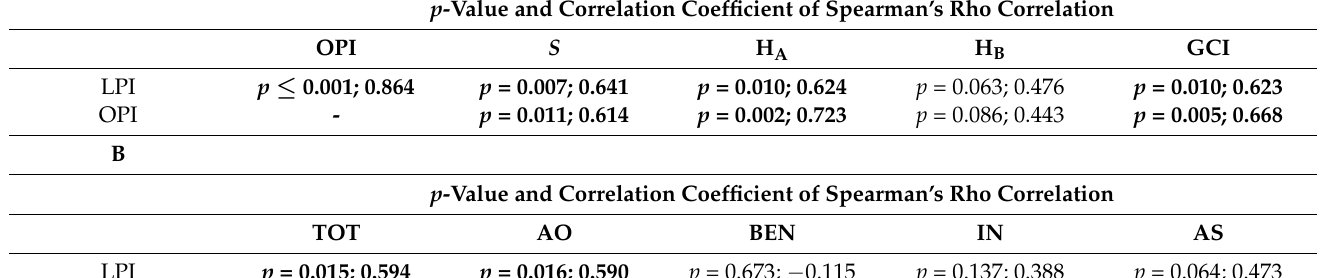
Table 5. Significance of correlations between plant glucosinolate content, larval preference index (LPI), and oviposition preference index (OPI) in the plants tested. Two-tailed Spearman’s rho correlations (n = 16) were performed. The effect of the diversity of glucosinolates was analyzed taking into account the glucosinolate richness ( S ), Shannon’s diversity index for the four glucosinolate classes (H A ), Shannon’s diversity index for the relative concentrations of all individual glucosinolates (H B ), and glucosinolate complexity index (GCI) for each plant ( A ). Besides total glucosinolate content (TOT), four different classes of glucosinolates were distinguished, aliphatic with sulfur-containing side chains (AS), other aliphatic (AO), benzenic (BEN), and indolic (IN) ( B ). Significant p -values ( p ≤ 0.05) are shown in bold